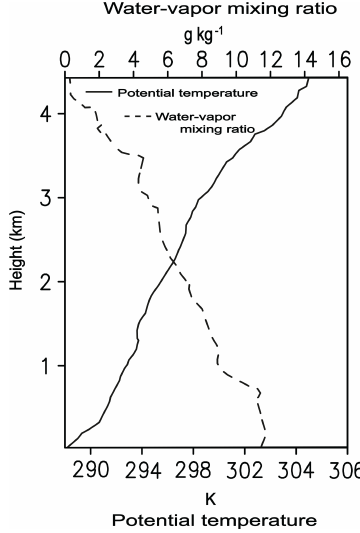
Figure 3. Vertical distributions of potential temperature and water vapor mixing ratio at 09:00LST on 13 April 2016. These distribu- tions are obtained from a radiosonde sounding near the simulation domain in Fig.